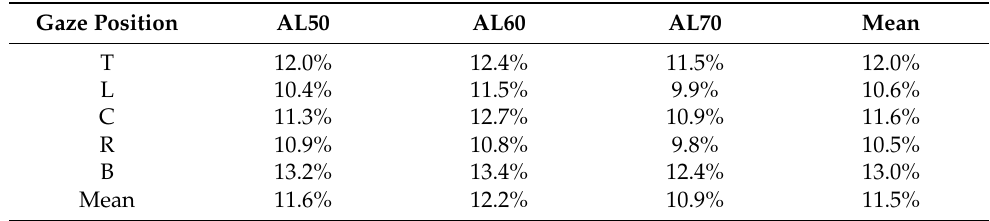
Table 3. Amount of saved power.